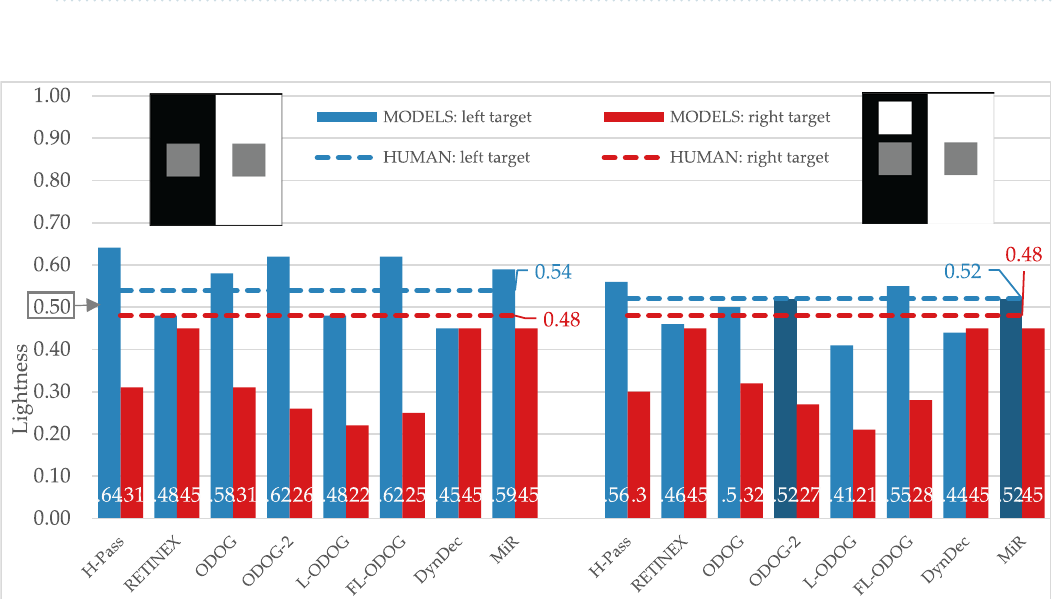
Figure 5. Empirical and model results for SLC and Maniatis variation of SLC displays, no significant difference from human data is annotated with the darker bars. The target lightness value is marked at 0.5 on the Y